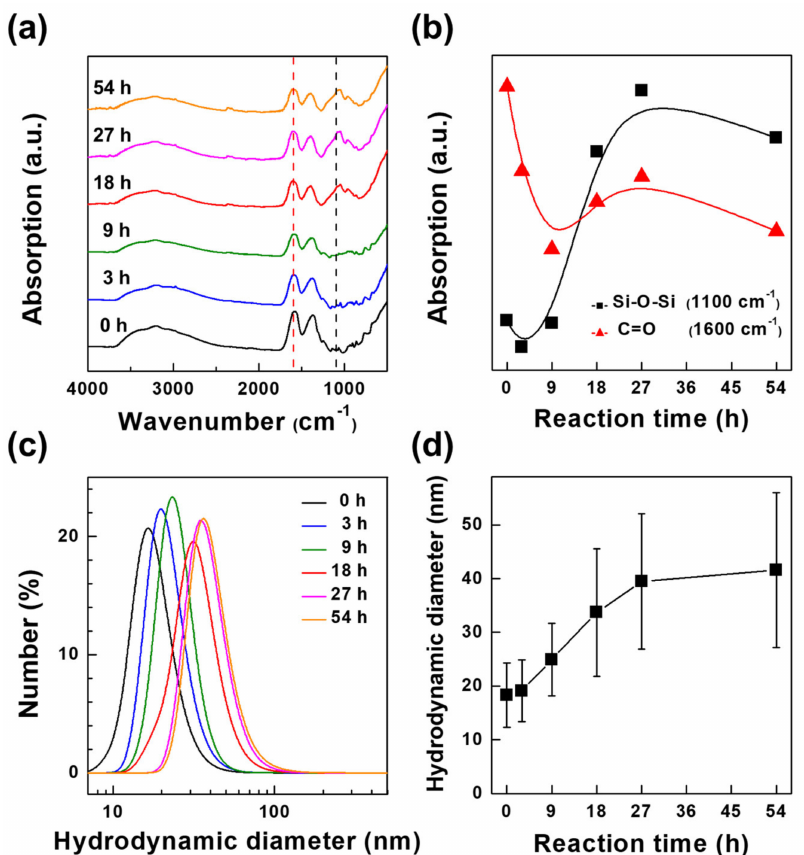
Figure 3. ( a ) FT-IR spectra of ZrO 2 @SiO 2 NPs with different reaction times. Dashed lines indicate the peak positions corresponding to (black) Si–O–Si and (red) C=O bonds, respectively. ( b ) Changes in absorption intensities of ZrO 2 @SiO 2 NPs according to the reaction time for (black) Si–O–Si and (red) C=O bonds. ( c ) Size distribution (hydrodynamic diameter) of ZrO 2 @SiO 2 NPs with different reaction times, measured by DLS analysis. ( d ) Changes in mean hydrodynamic diameter of ZrO 2 @SiO 2 NPs according to the reaction time. The error bar represents the standard deviation in the hydrodynamic diameters of the